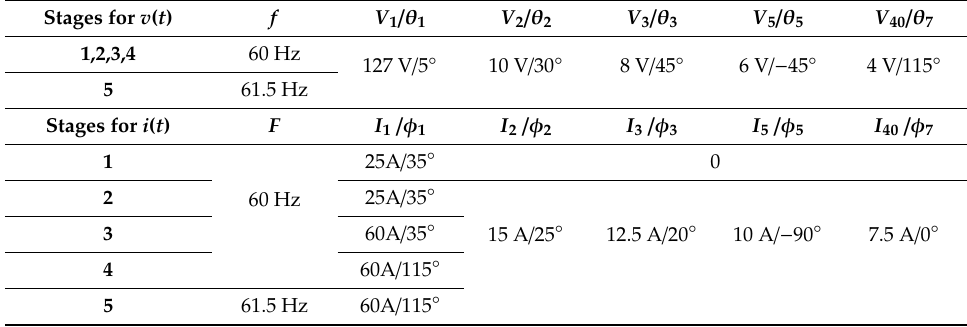
Table 4. Values for synthetic signals.